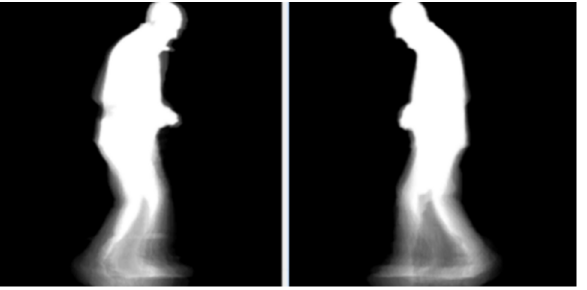
Figure 4. Examples of walking forward ( right ) and walking backward ( left ) of a gait energy map.